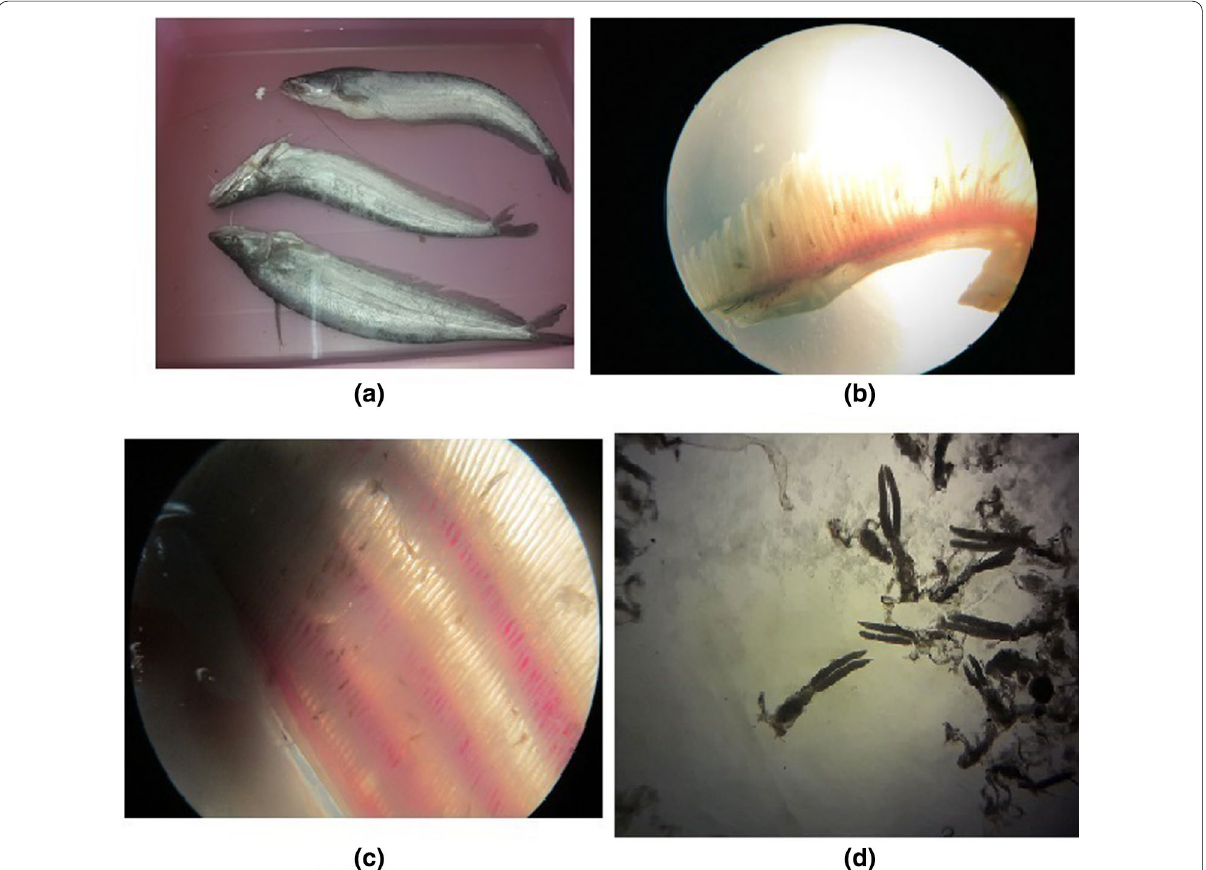
Fig. 2 a Wallago attu infested with ectoparasites, b Gill rakers of W. attu showing adult and larval stages of Ergasilus malnadensis and monogeneans Thaparocleidus indicus and T. wallagonius , c adult copepod, E. malnadensis attached to the gill rakers of W. attu , d adult copepod, E. malnadensis in embryo